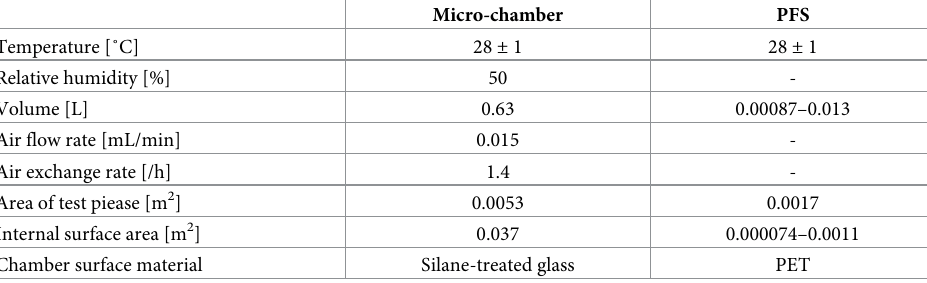
Table 1. Test condition for micro-chamber and